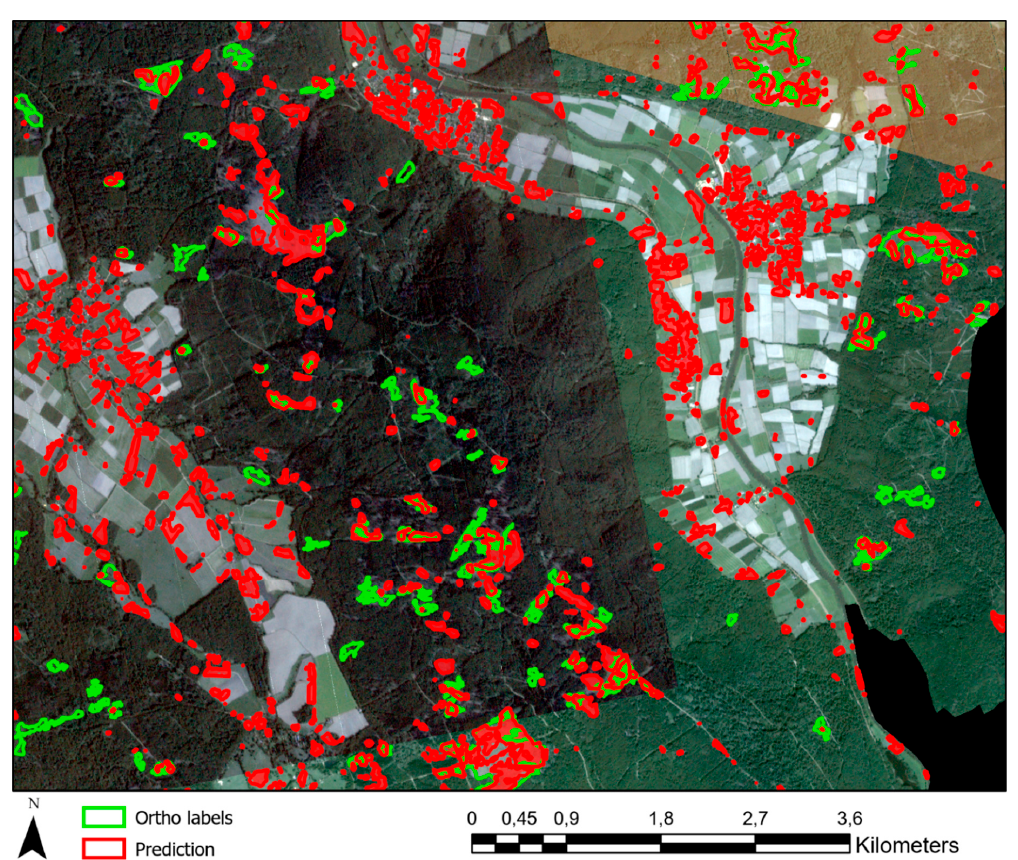
Figure 11. Prediction on a satellite image (red) from Hesse compared to the labels (green). Note that the labels are not complete and of bad quality (see methods section). Spectral differences in the Planet data are due to different acquisition dates.